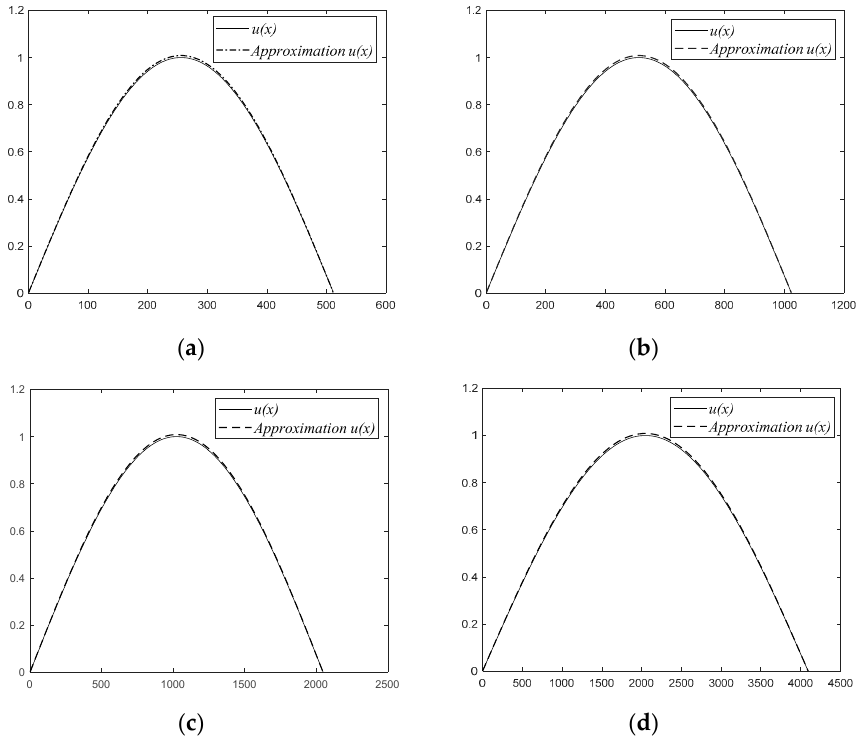
h Ω Figure 6. Approximation solutions in Ω h by Algorithm 3 V.M, ( a ) Ω h = 512, ( b ) Ω h = 1024, Figure 6. Approximation solutions in by Algorithm 3 V.M., ( a ) h Ω = 512, ( b ) h Ω = 1024, ( c ) Ω h = 2048 and ( d ) Ω h = ( c ) h Ω = 2048 and ( d ) h Ω = 4096